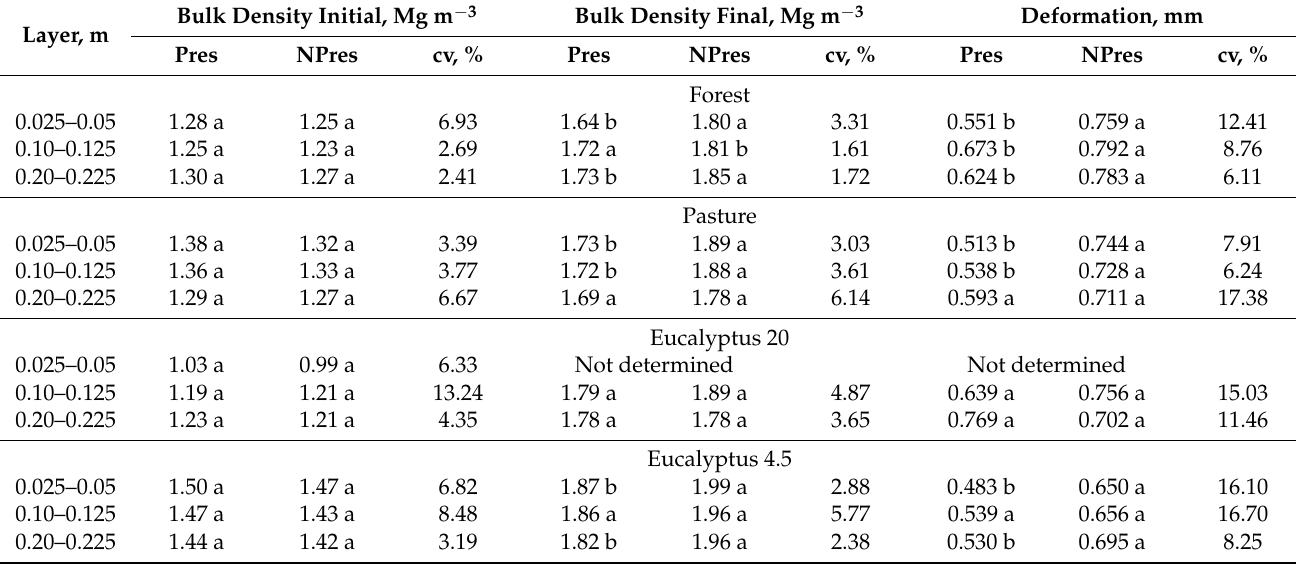
Table 3. Coefficient of variation (cv) and mean values of bulk density in the beginning and in the end of the uniaxial compression test, and deformation, for soil with preserved (Pres) and non-preserved (NPres) structure under different land uses and layers.